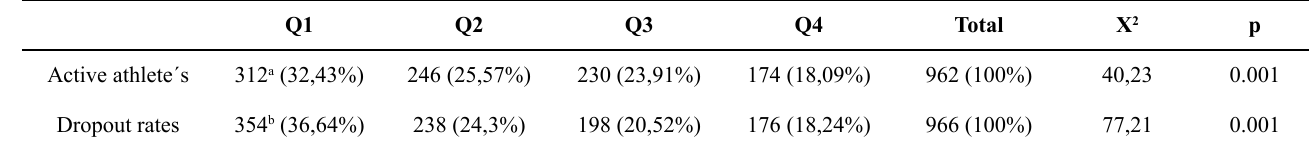
Table 1. Active athletes and total dropout distribution rates from youth teams in 2014, 2015 and 2016 seasons Q1 Q2 Active athlete´s Dropout